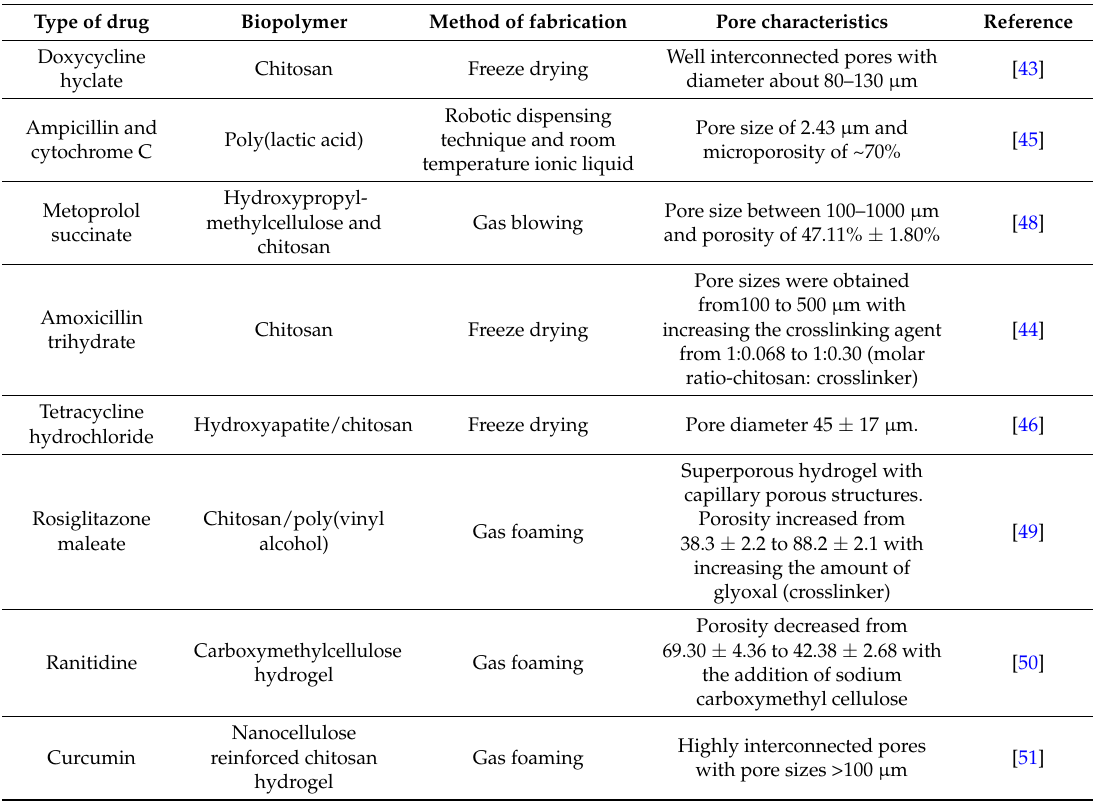
Table 3. Pore characteristics of different drug delivery systems prepared from various fabrication method